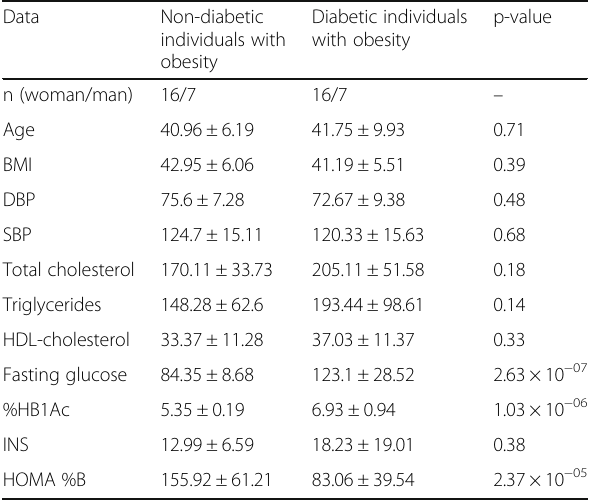
Table 1 Anthropometric data of non-diabetic individuals with obesity and diabetic individuals with obesity